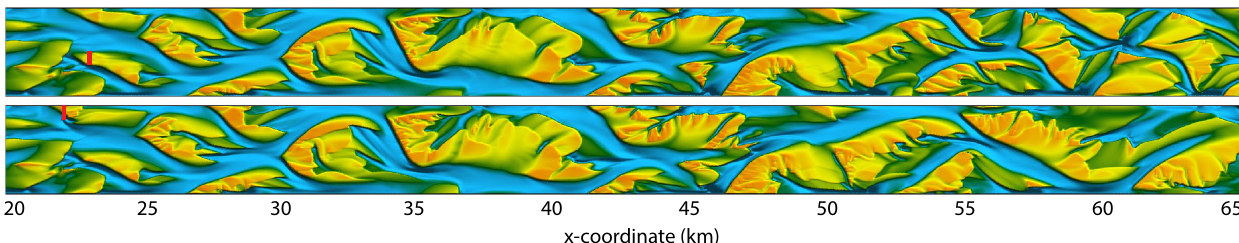
Figure 12. Bed levels in month 15, 3 months after building of the structures in Run A4 at x = 23km (top) and in Run A5 at x = 22km